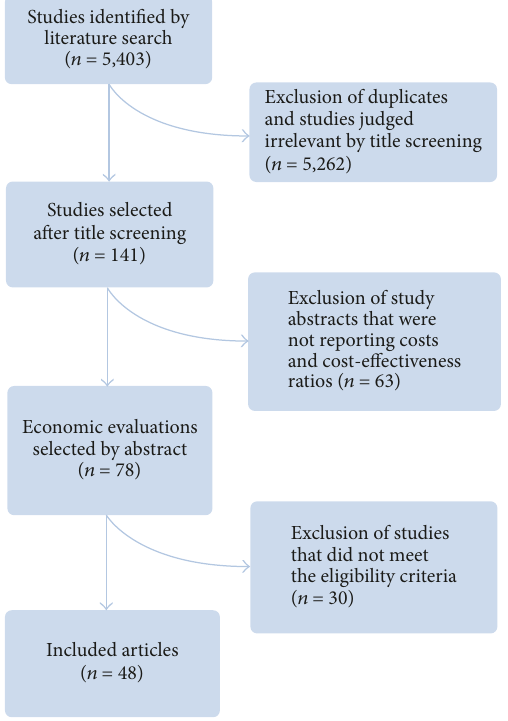
Figure 1: Study flowchart.